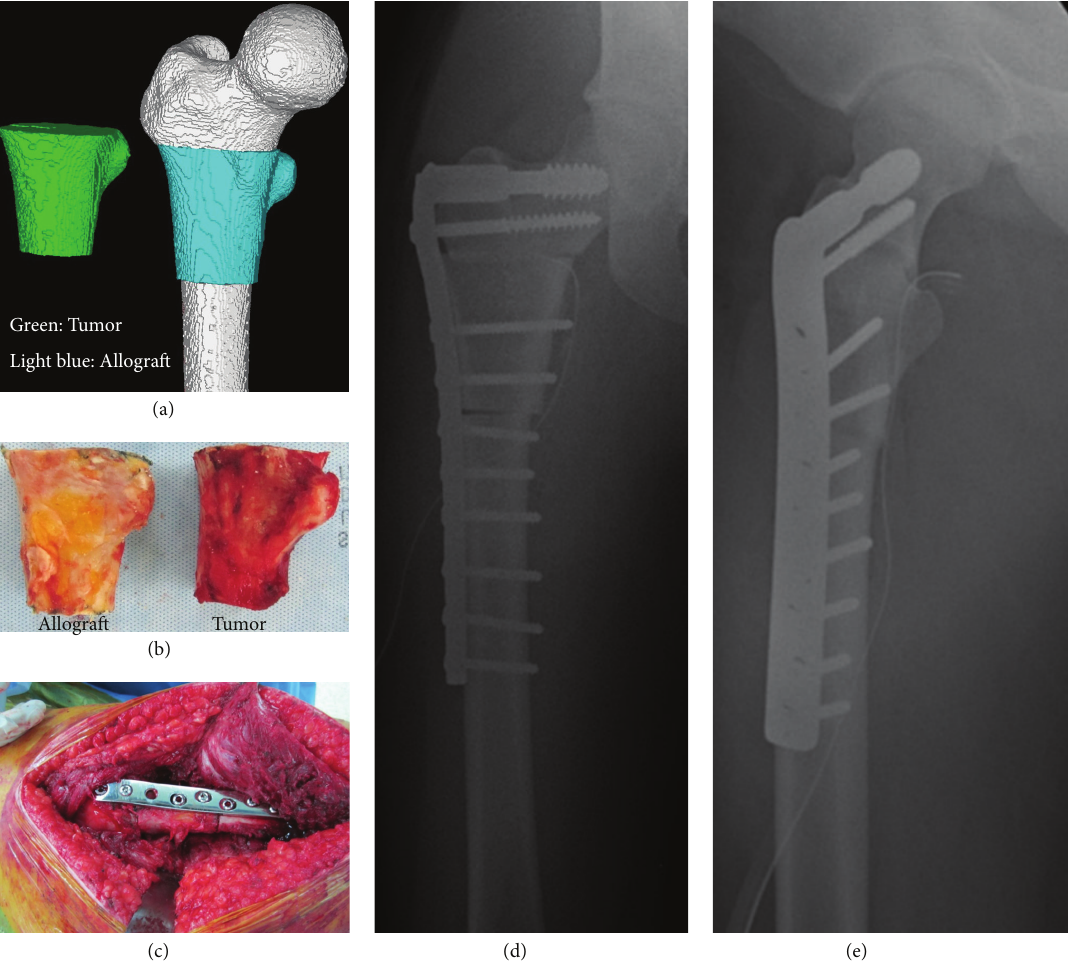
Figure 4: (a) Bone allograft was selected according to the shapes comparison between host and donor. The original tumor diagnosis was a chondrosarcoma. (b) Allograft was selected and tumor was resected. (c) Allograft was fixed in the patient through a plate and screws. (d) and (e) Postoperative